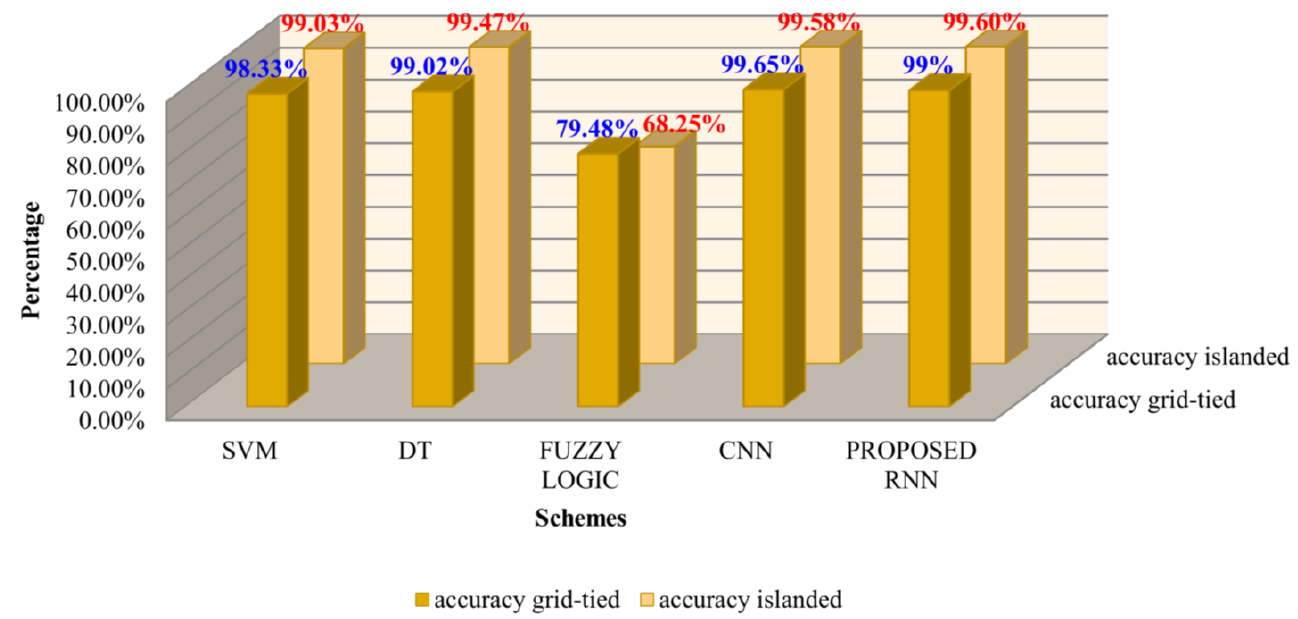
Figure 12. Accuracy comparison of proposed scheme with existing benchmark.